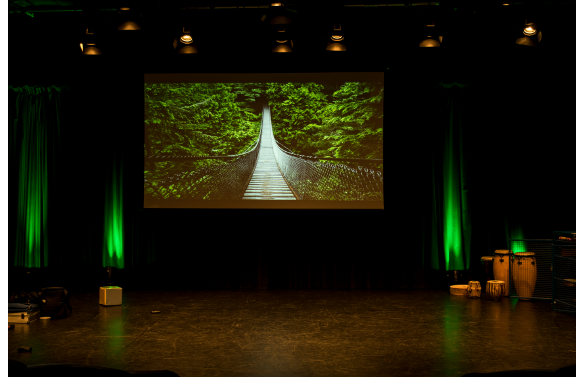
Figure 1. Jungle themed environment with rope